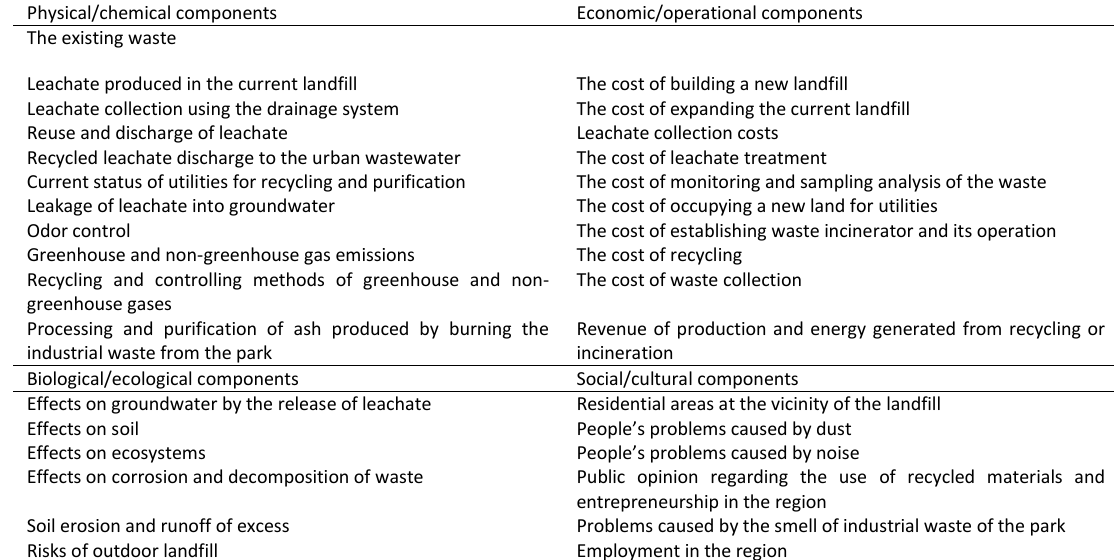
Table 5: The assessed indices and their subsections